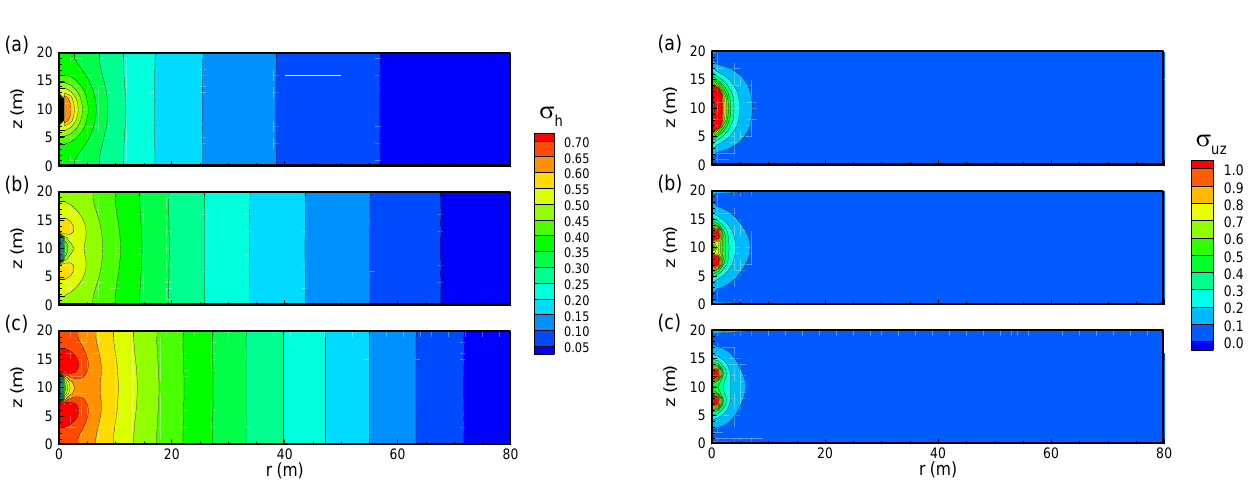
Fig. 4. The solutions of head standard deviation at t = 80day for the illustrated examples: (a) r -correlation length ( λr )=1.0m, (b) r -correlation length ( λr )=5.0m, and (c) r-correlation length ( λ r)=10.0m.